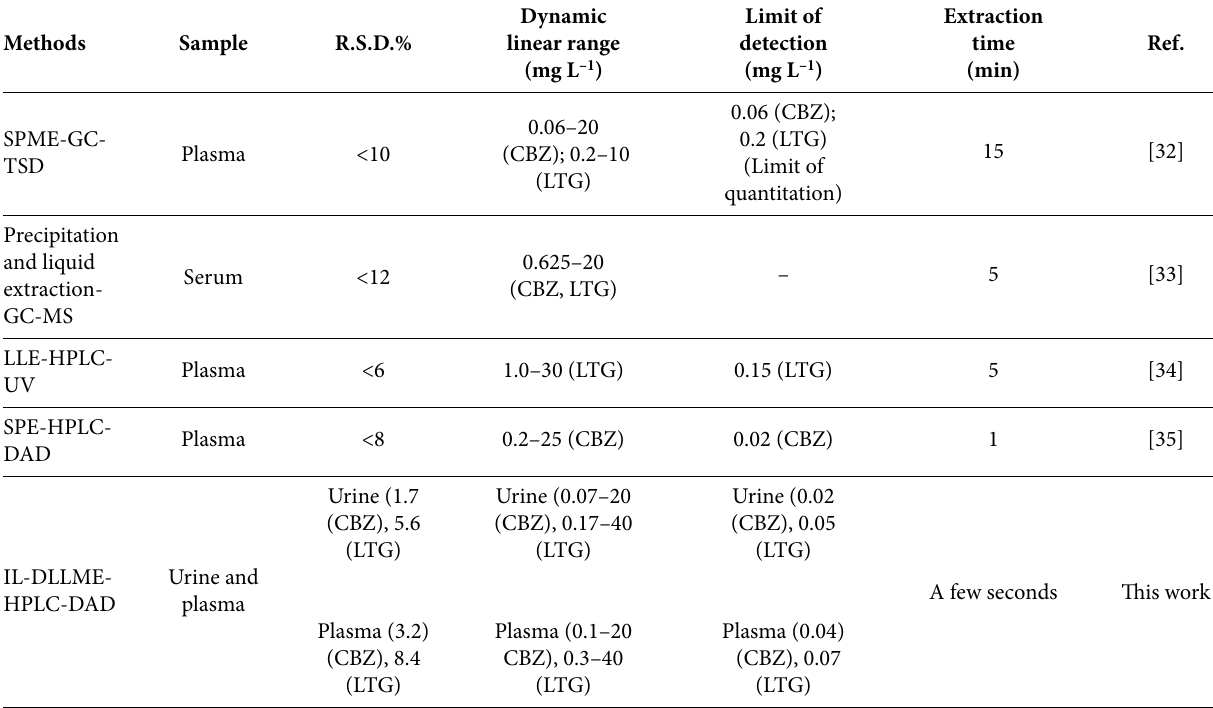
Table 3. Comparison of the proposed method with other extraction methods for the determination of carbamazepine (CBZ) and lamotrigine